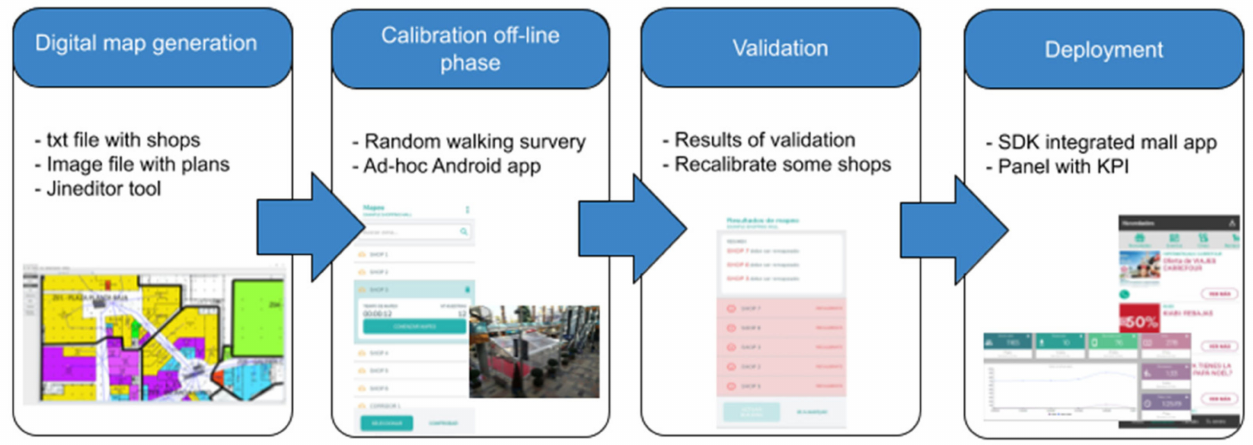
Figure 3. Phases of IPS